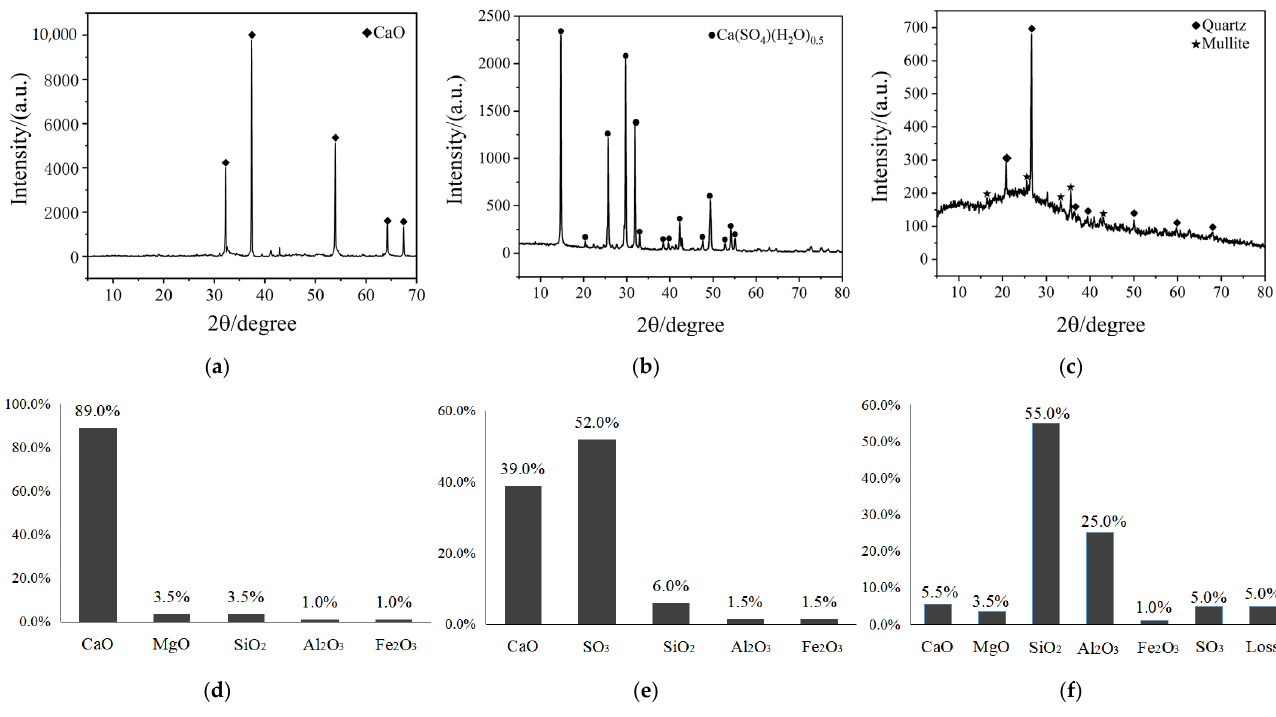
Figure 3. Experimental materials. ( a ) XRD pattern of quicklime; ( b ) XRD pattern of gypsum; ( c ) XRD pattern of fly ash; ( d ) chemical element content of quicklime; ( e ) chemical element content of gypsum; ( f ) chemical element content of fly ash. Here, XRD indicates X-ray diffraction analysis.